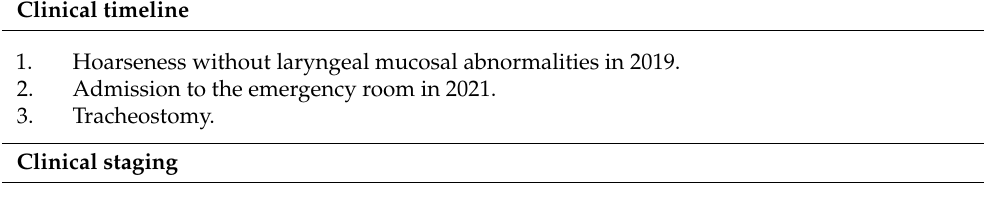
Table 1. Clinical synopsis of the laryngeal adenoid cystic carcinoma.